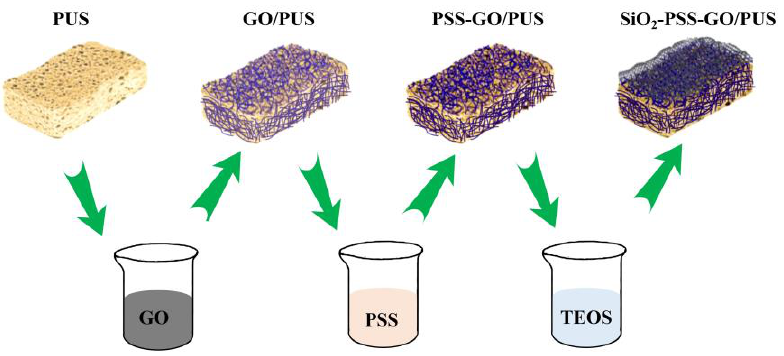
Figure 1. Schematic diagram of the preparation process of modified PUS.